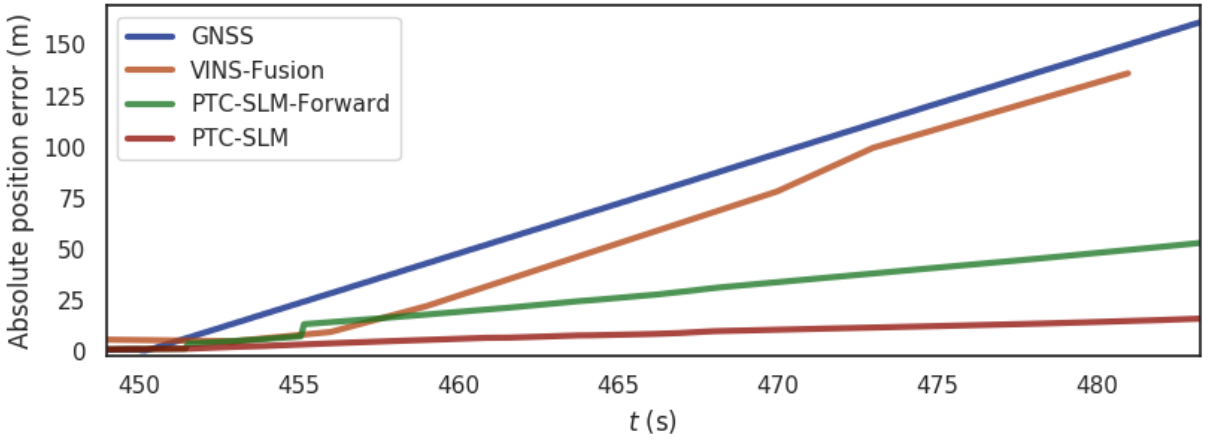
Figure 14. The absolute position error of the four methods in rural scene .